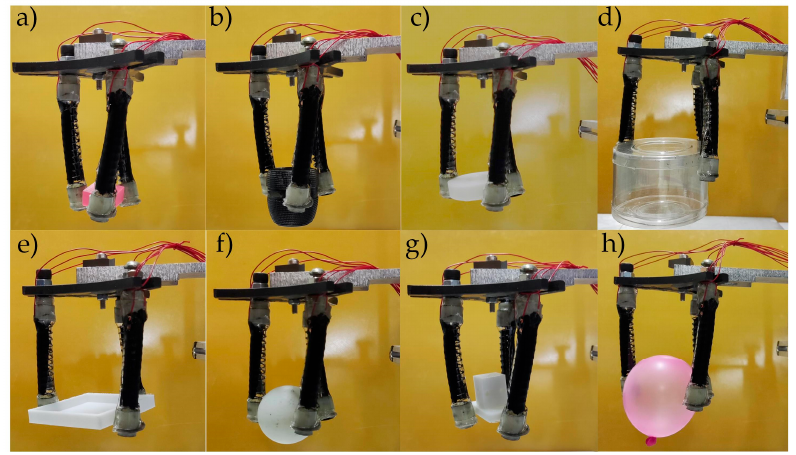
Figure 15. Grasping objects with different shapes: ( a ) cube (20 mm); ( b ) cylinder (24 mm); ( c ) cylinder (31 mm); ( d ) cylindrical box (60 mm); ( e ) cube (50 mm); ( f ) table tennis ball (30 mm); ( g ) irregular objects (20 mm); ( h ) balloon (55 mm).